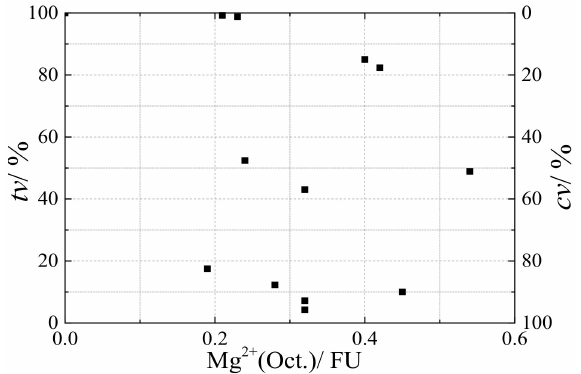
Figure 10. Relationship of the proportion of tv and cv layers to octahedral Mg 2 +